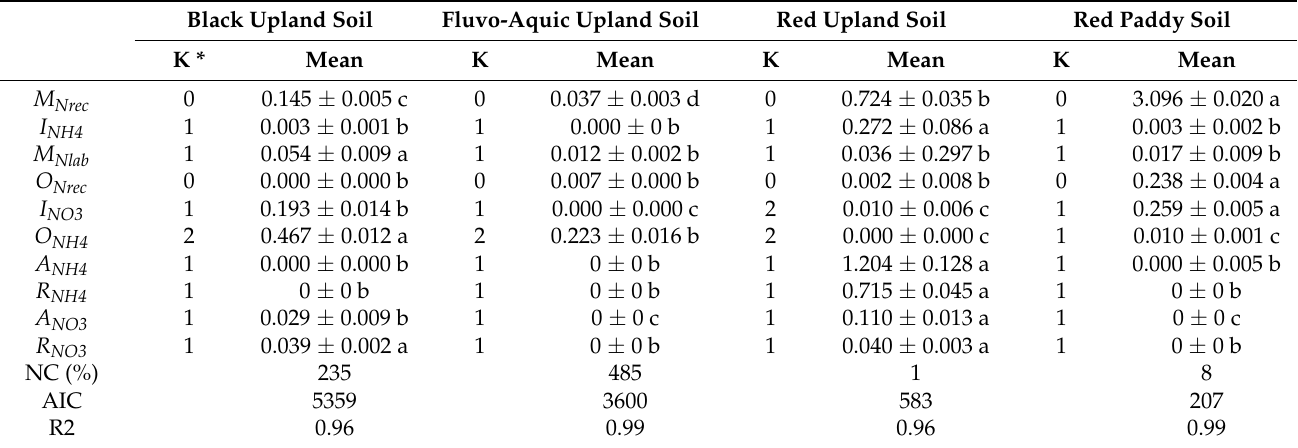
Table 3. Gross N transformation rates (mg N kg − 1 day − 1 ) for the different soil types (Mean ± SD). Black Upland Soil Fluvo-Aquic Upland Soil Red Upland Soil Red Paddy